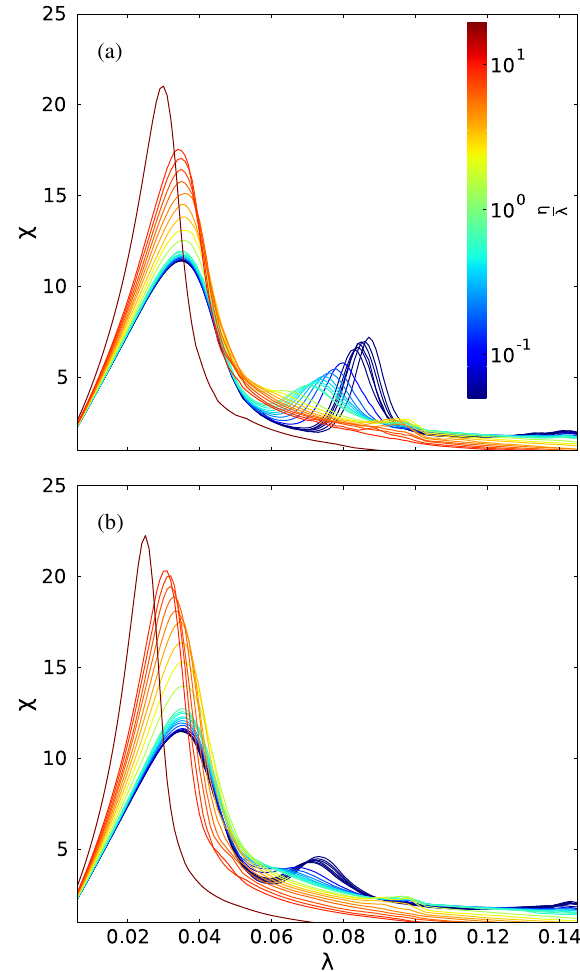
FIG. 9. Susceptibility χ as a function of λ considering all three- layer configurations and many different ratios η = λ , which is represented by the color of the lines. The recovering rate is μ ¼ 1 . The simulated values are ð η = λ Þ ¼ 0 . 05 , 0.06, 0.07, 0.08, 0.09, 0.1, 0.2, 0.3, 0.4, 0.5, 0.6, 0.7, 0.8, 0.9, 1.0, 2, 3, 4, 5, 6, 7, 8, 9, 10, 20. In panel (a), we show the line ð 2 . 3 þ 2 . 9 þ 2 . 6 Þ , while panel (b) is the multiplex